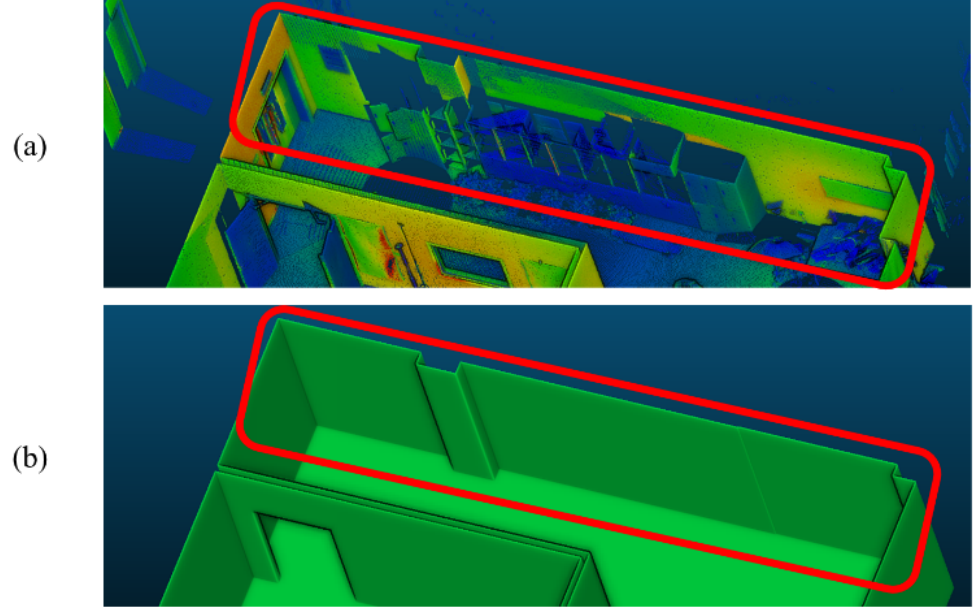
Figure 12. ( a ) Surfaces with occlusions in Site 3, ( b ) the corresponding model constructed. Table 3. Comparison of the most time-consuming cases between our approach and other methods. Ref.